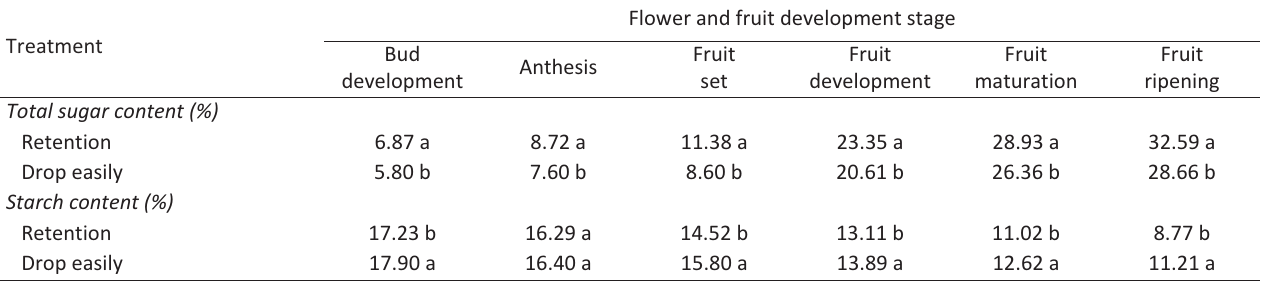
The number followed by the same letter in the same column each fruit development is not significantly different in the t­test at the level